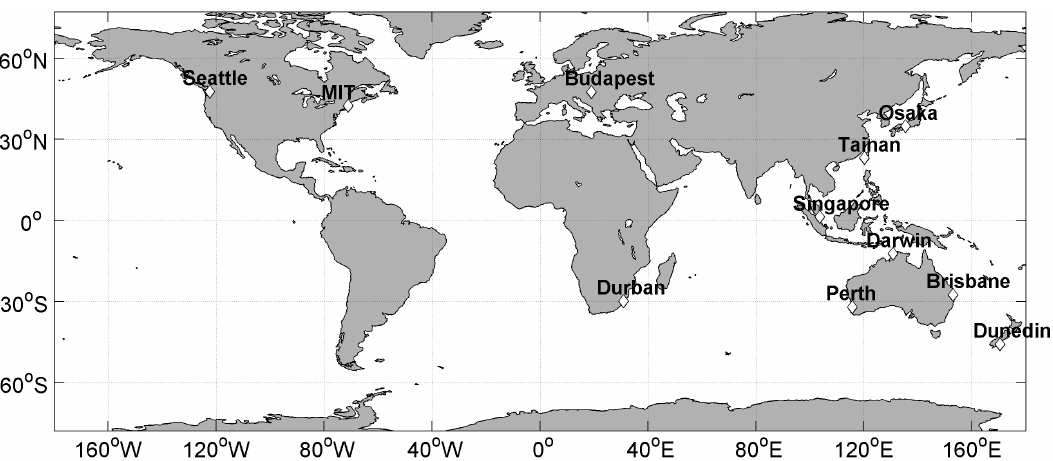
Fig. 1. Locations of the 11VLF receiving stations (shown as diamonds) currently returning lightning trigger times to the central processing point in Dunedin, New Zealand. Table 1. Locations and hosts of the 11 VLF receiving stations currently operating in the VLF WorldWide Lightning Location Network. Location Latitude (N) Longitude (E) Host Dunedin − 45.8639 170.514 University of Otago Darwin − 12.3718 130.868 Northern Territory University Perth − 32.0663 115.836 Murdoch University Brisbane − 27.5534 153.052 34.8232 135.523 1.2971